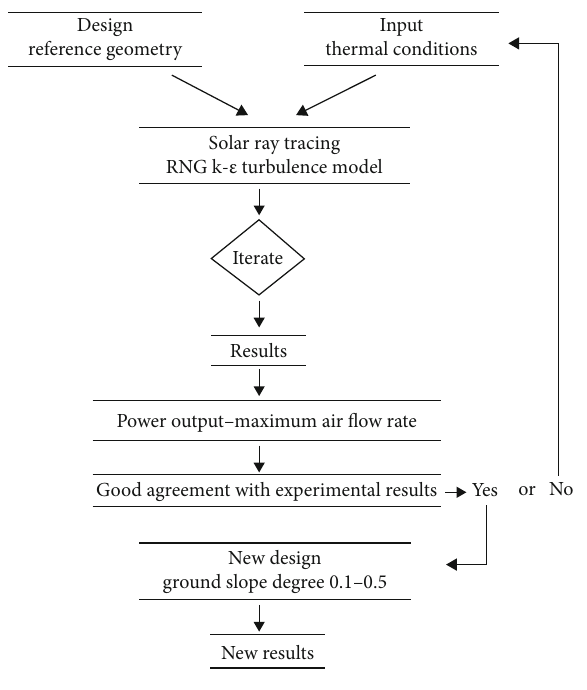
Figure 2: Experimental procedure. Table 4: Mesh-independent solution over maximum air